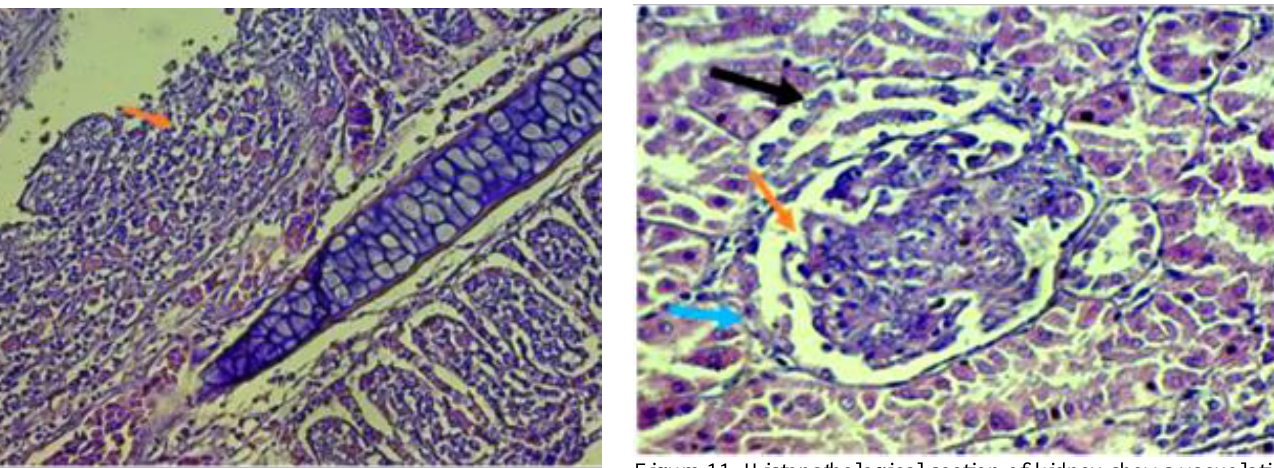
Figure 8. Histopathological section of gills shows fusion and hyperplasia of primary and secondary lamella (